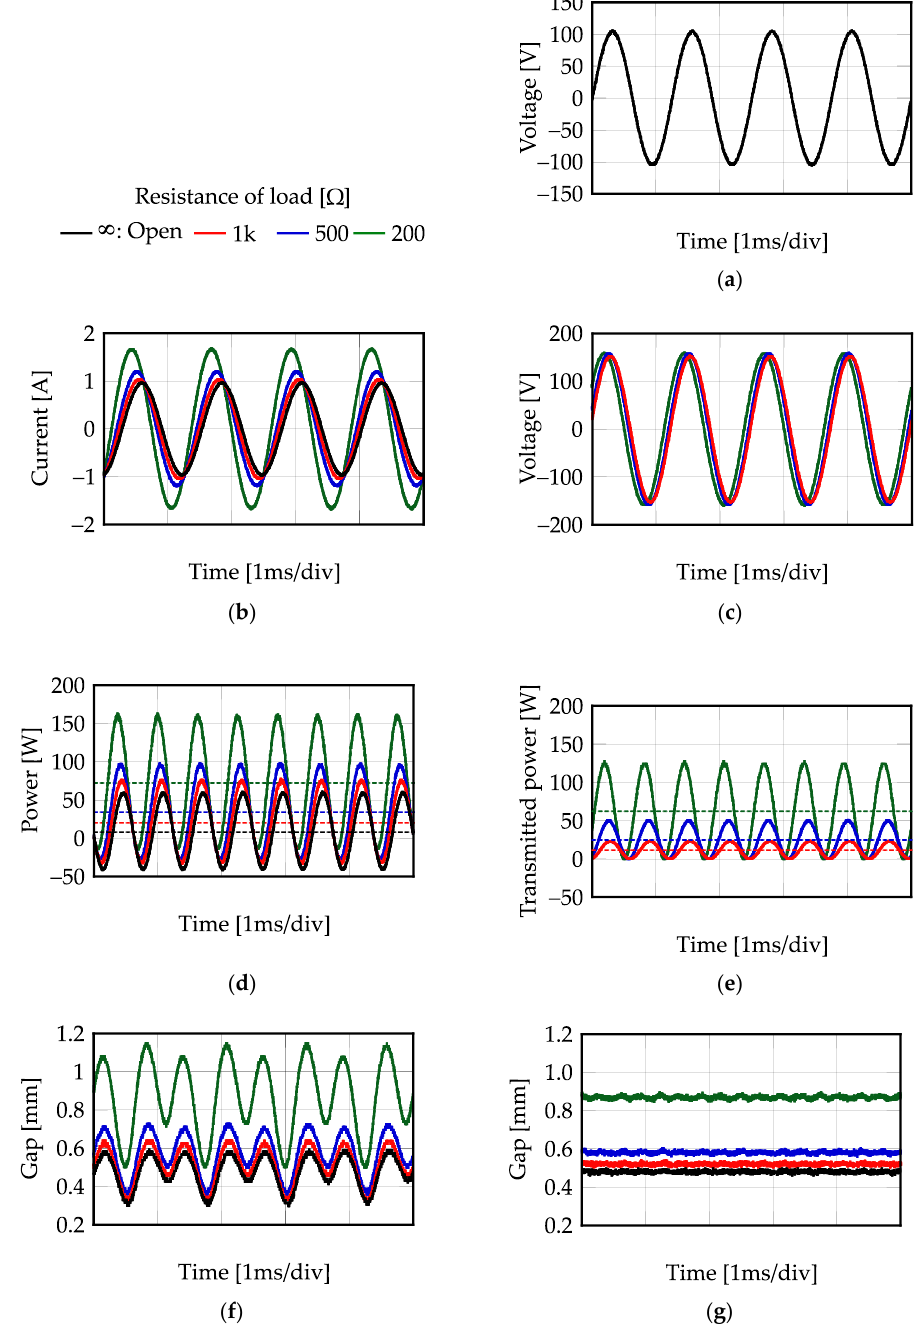
Figure 20. Time histories of system with various load resistances. ( a ) Applied voltage for primary electromagnet. ( b ) Current of primary electromagnet. ( c ) Voltage of secondary electromagnet. ( d ) Input power. ( e ) Transmitted power. ( f ) Gap(Sensor signal). ( g ) Gap(With noise elimination). A constant-amplitude voltage was applied to the primary electromagnet as shown